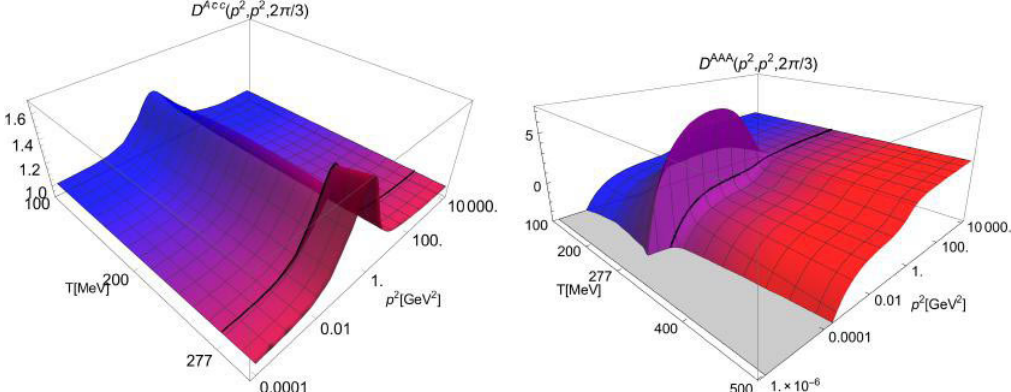
Figure 8. Left: Temperature dependence of the ghost-gluon vertex dressing function at the symmetric point. Right: Temperature dependence of the three-gluon vertex dressing function at the symmetric point. In both plots the black line denotes the phase